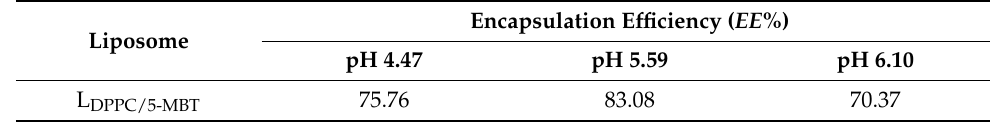
Table 1. Percentage of 5-MBT encapsulation in the liposomes obtained at different pH.